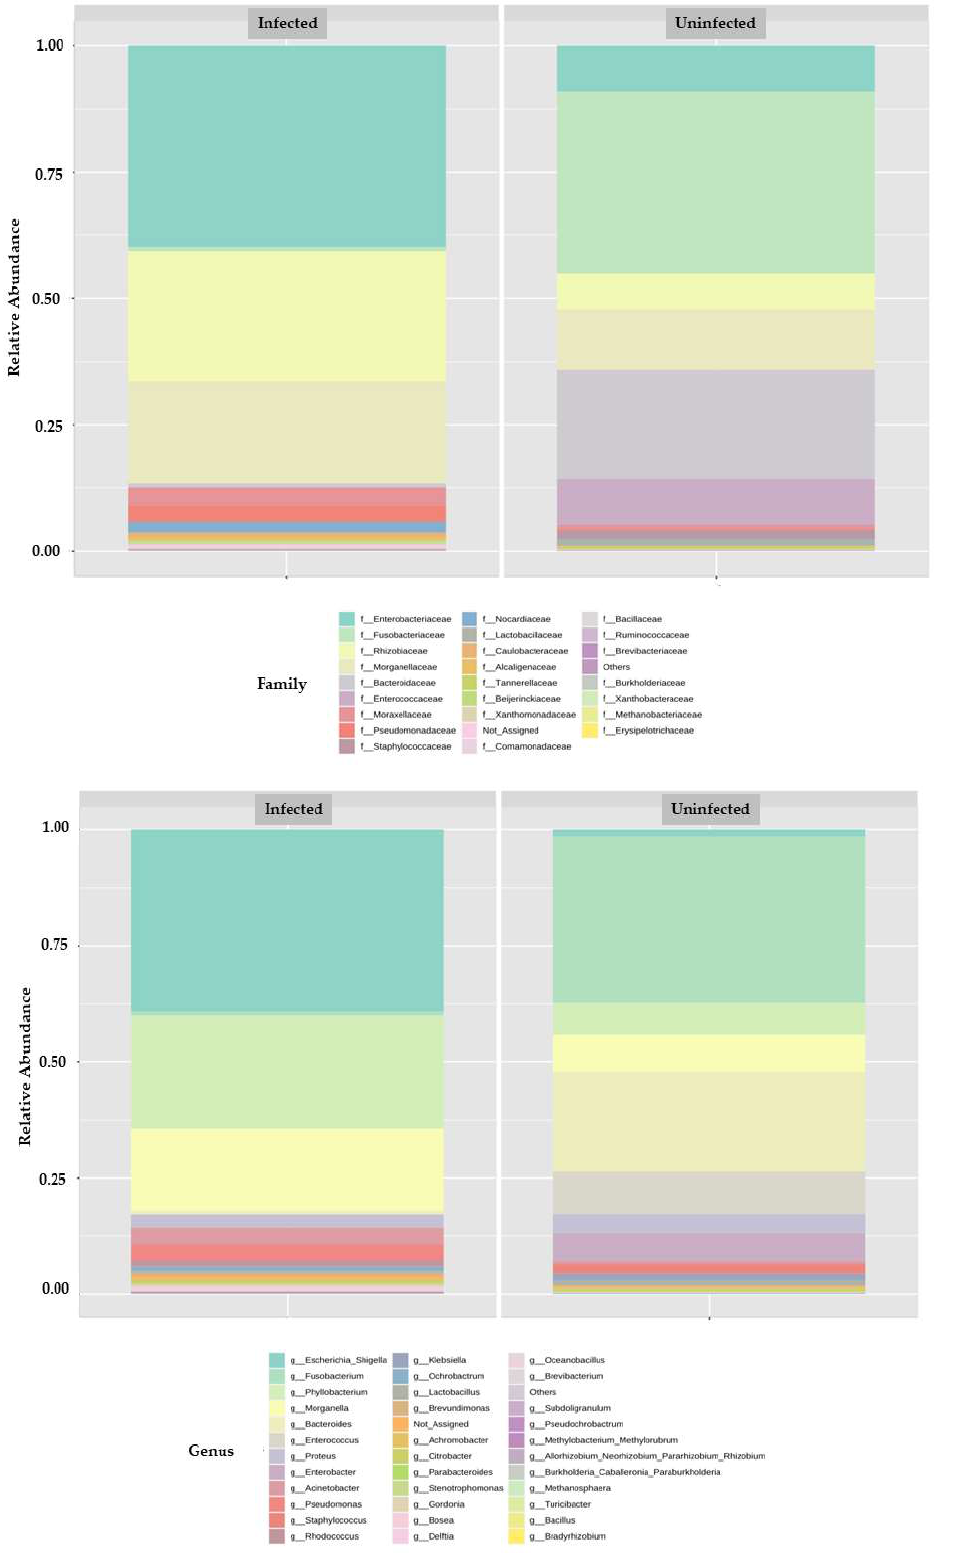
Figure 2. Operational taxonomic units (OTUs) presentation and analysis of micro bacteria from Phylum to Species level showing >1% relative abundance between Infected and Uninfected host gut: ( a ) Phylum level; ( b ) Class level; ( c ) Family level; ( d ) Genus level.